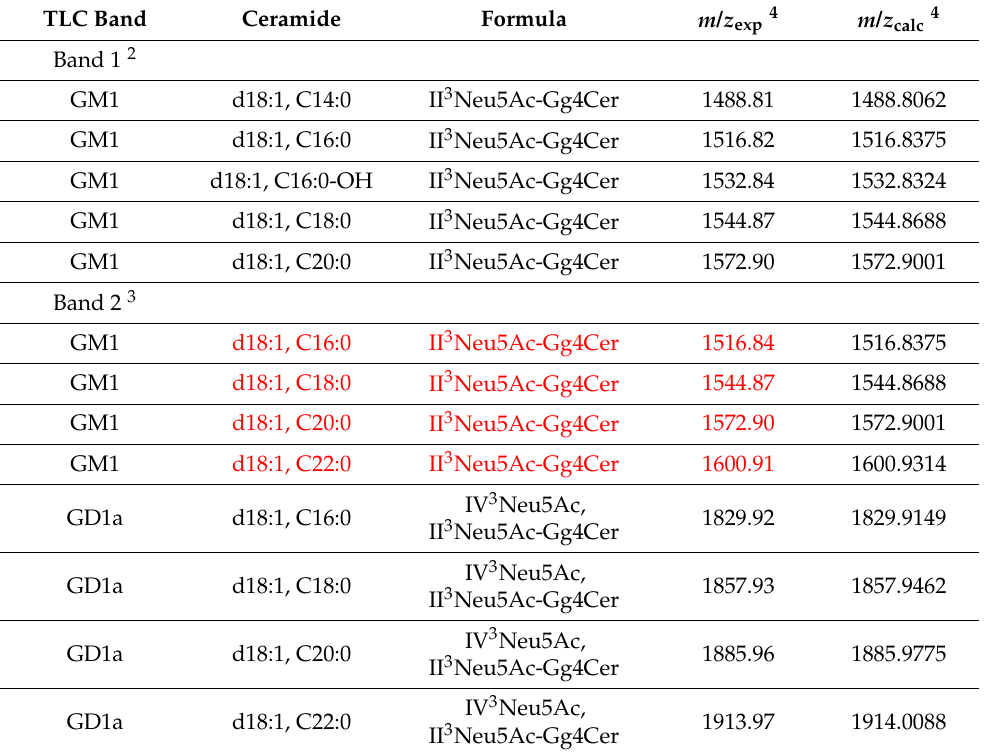
Table 2. Proposed structures of GM1 and GD1a-derived GM1 species of pHCoEpiCs obtained by V. cholerae neuraminidase treatment 1